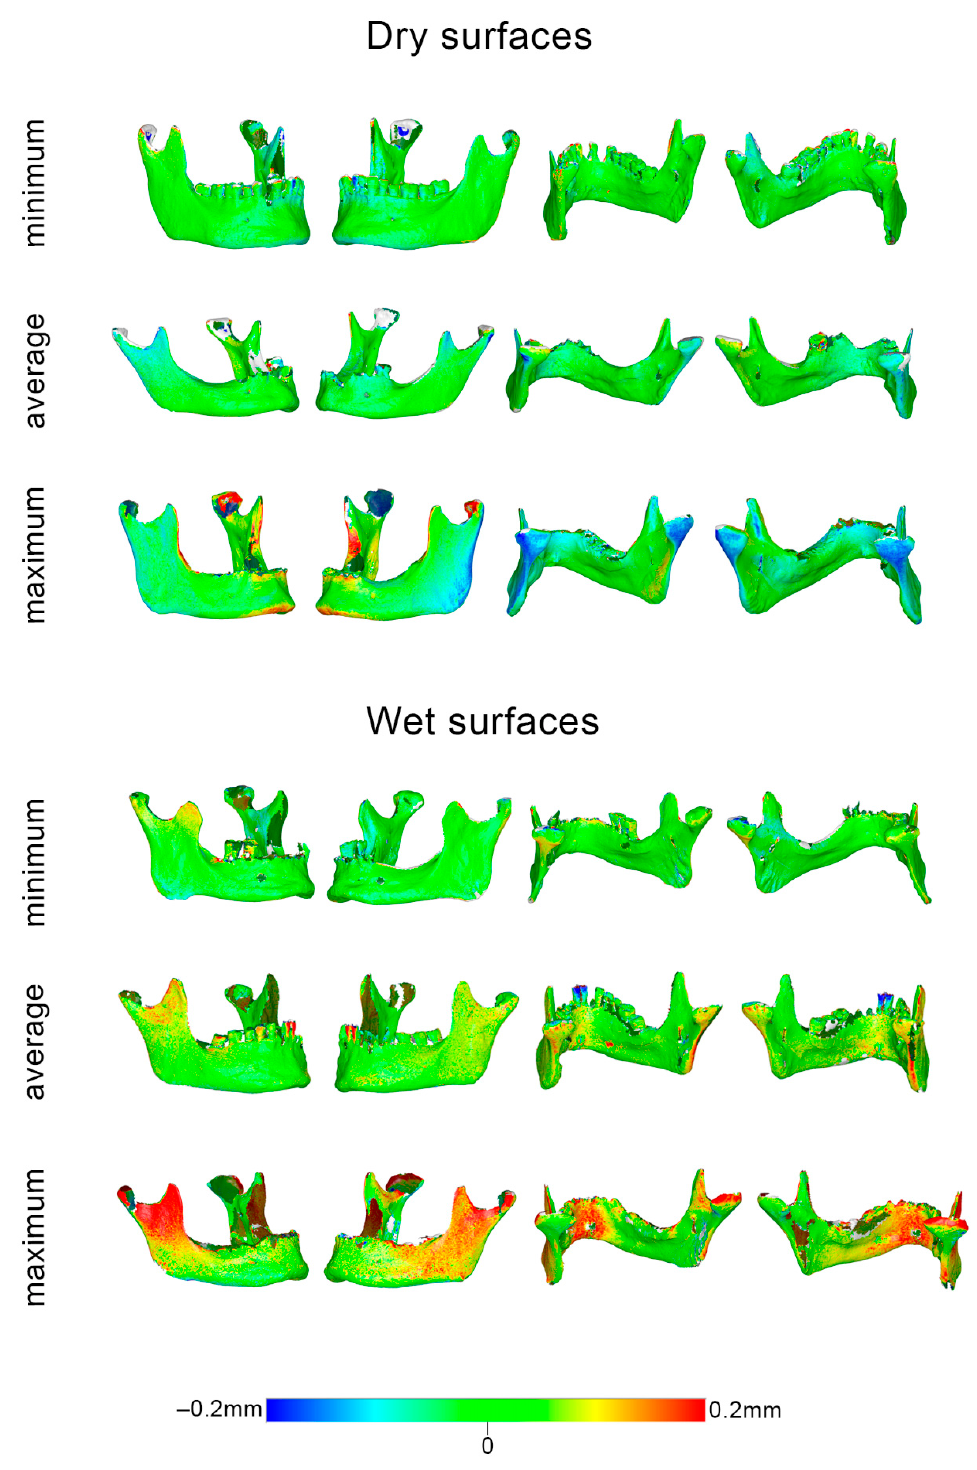
Figure 6. Color-coded distance maps of mandibles showing the scanner reproducibility in dry and wet conditions, depicted through models that corresponded to the minimum, average, and maximum error detected in the pre-specified measurement areas. Zero distance between best-fit-approximated repeated scans indicates perfect reproducibility.